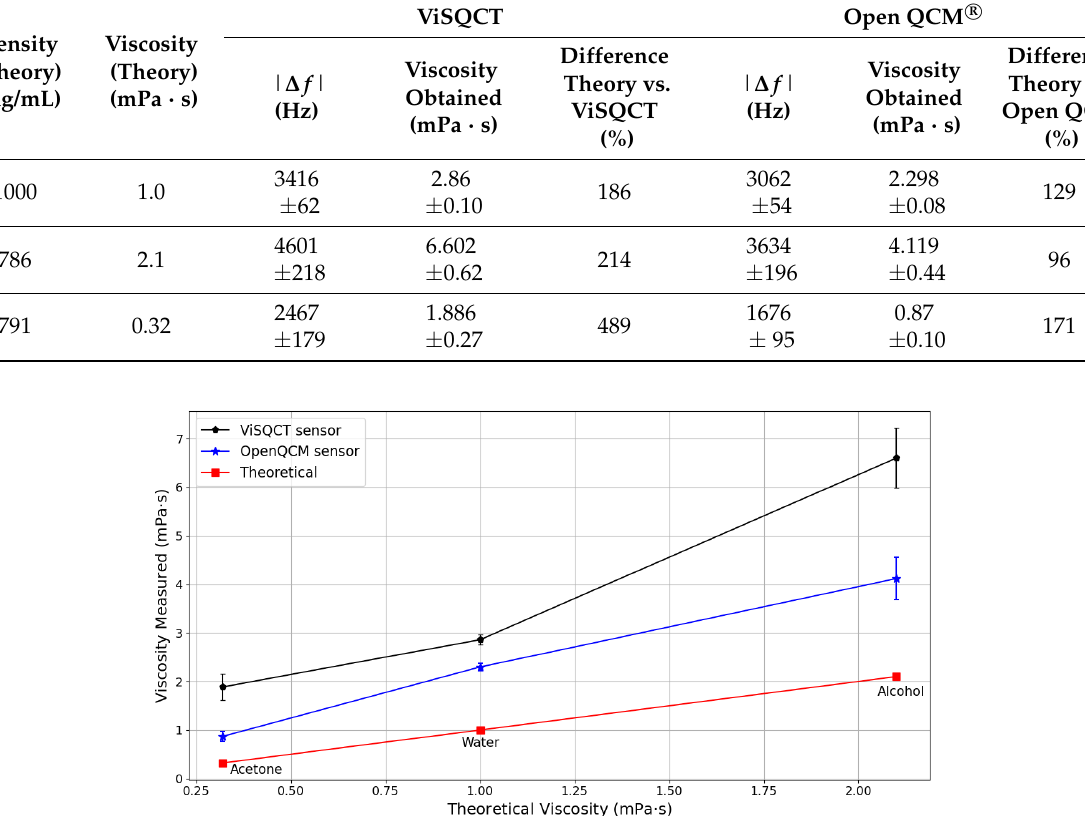
Table 3. Water, Alcohol, and Acetone results.